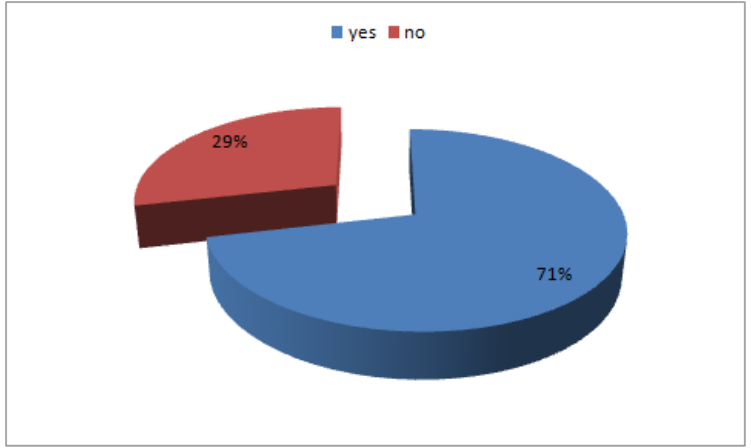
Figure 6: Better Electronic Services Compared to Other